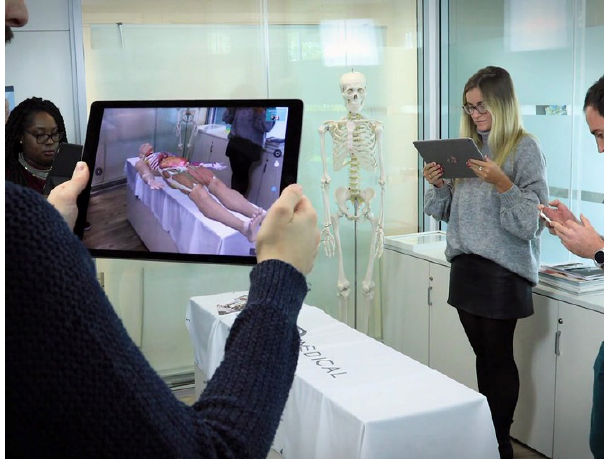
Image courtesy of Complete